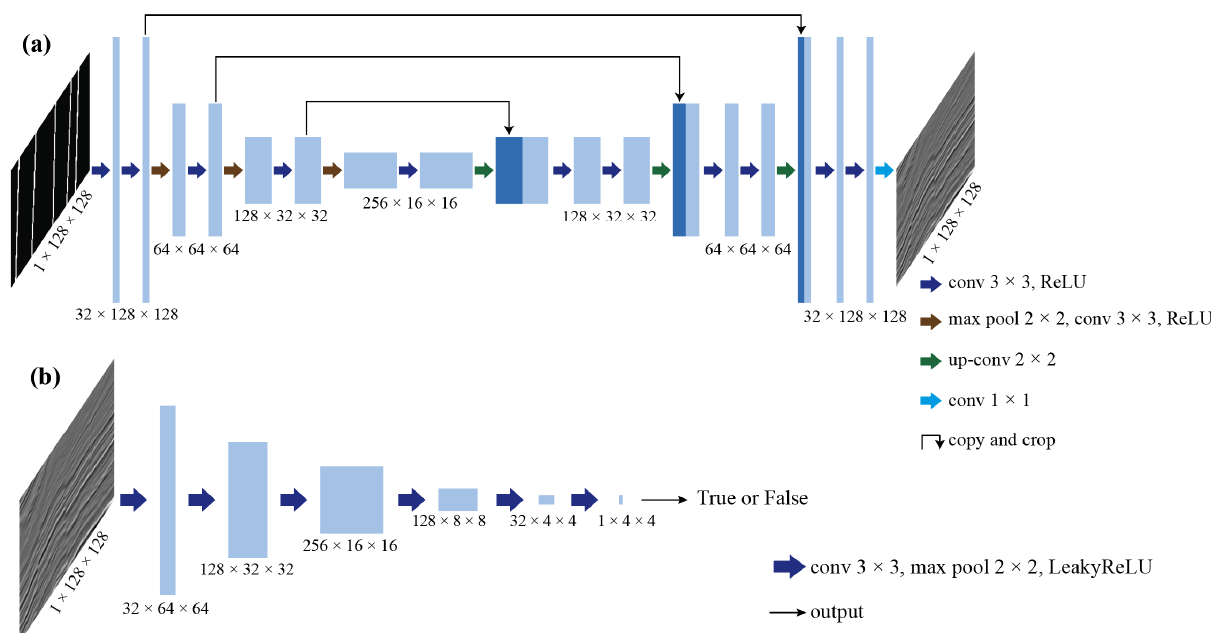
Figure 2. Label-to-data network structure.